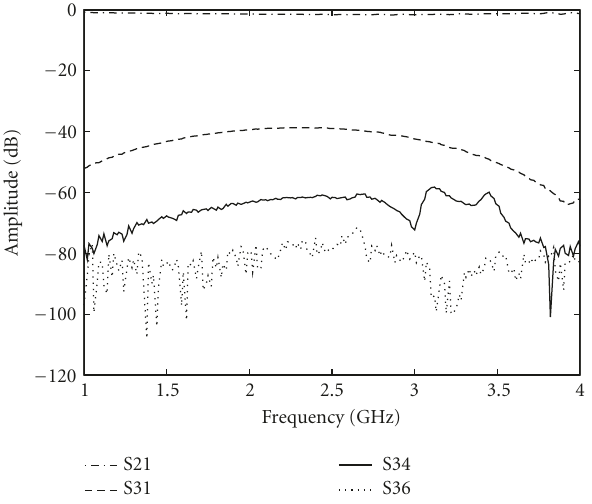
Figure 18: The measured phase imbalance of the 2 × 2 coupler.